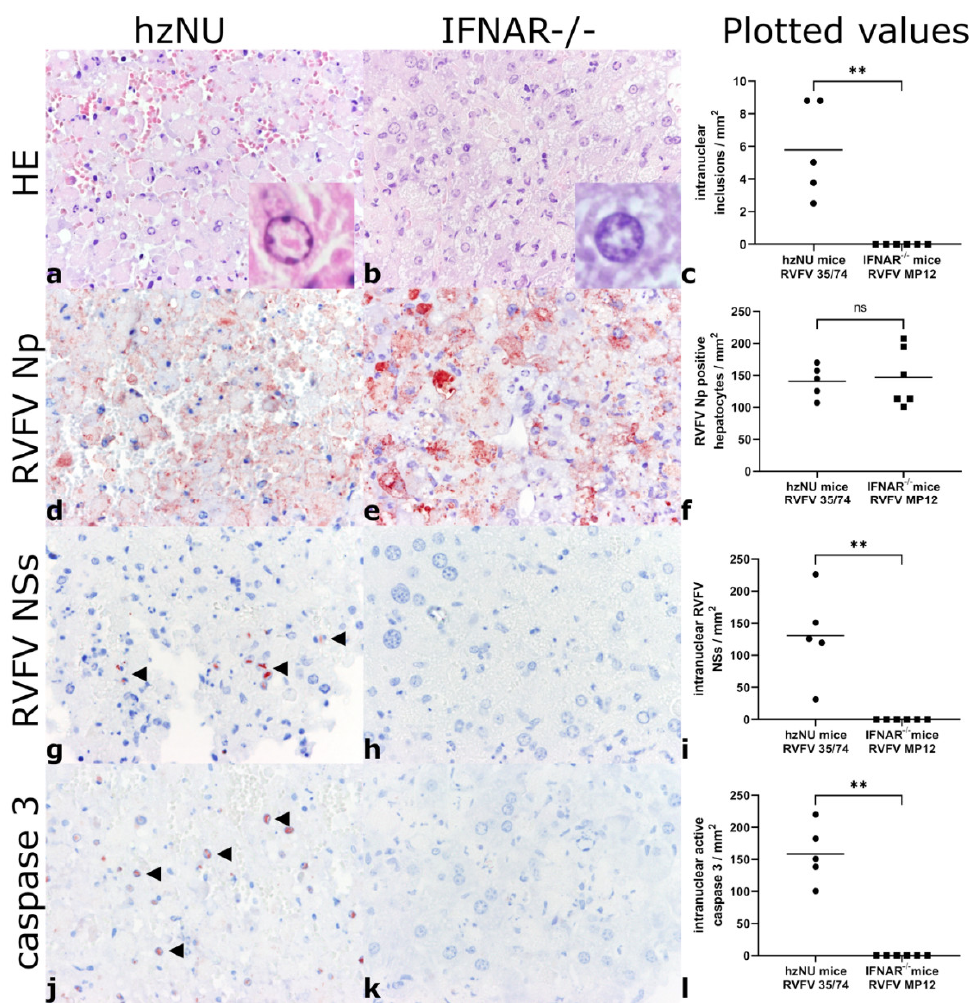
Figure 1. Histology and immunohistochemistry: HE-stained slides exhibit diffuse hepatic necrosis and apoptosis in RVFV 35/74-infected hzNU mice ( a ) and RVFV MP12-infected IFNAR −/− mice ( b ). Insets: high magnification of intranuclear inclusion ( a ) and control nucleus from uninfected placebo mouse ( b ). Intranuclear inclusions are present in hzNU mice only ( c ). IHC labelling of RVFV Np shows diffuse expression throughout the samples ( d , e , f ). Intranuclear RVFV NSs accumulation in RVFV 35/74 infected hzNU mice ( g ), but not in RVFV MP12-infected IFNAR −/− mice ( h ). Statistical analysis reveals increased intranuclear NSs in RVFV 35/74 only ( i ). Intranuclear active caspase-3 accumulation in RVFV 35/74-infected hzNU mice ( j ), but not in RVFV MP12-infected IFNAR −/− mice ( k ). Statistical analysis reveals increased intranuclear active caspase-3 in RVFV 35/74 only ( l ). Statistical significance of the cell counts was determined by the Mann–Whitney U test: **: p < 0.01; ns: not significant. Abbreviations: hzNU: heterozygous Crl:NU(NCr)-Foxn1nu mice; IFNAR − / −